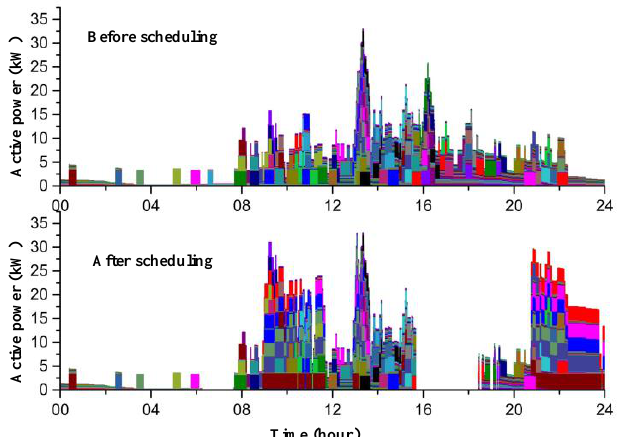
Figure 8. Simulation results of the simplified temperature state priority list control strategy. Figure 9. Real time active power consumption of 100 domestic electric water heaters based on the simplified temperature state priority list method.